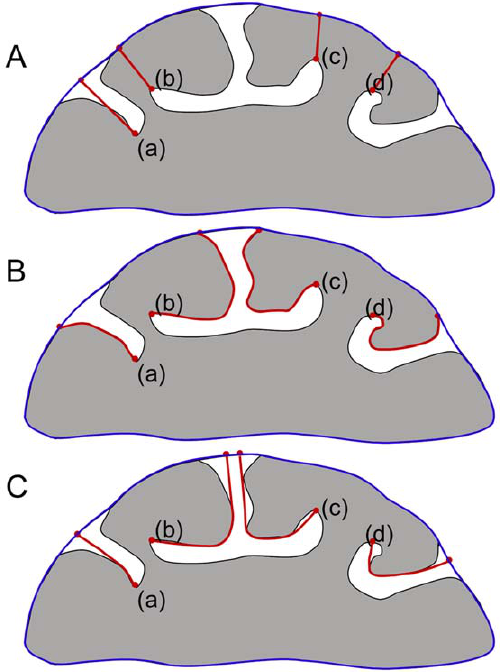
Figure 1. Illustration of algorithms for computing sulcal depth: (A) EUD, (B) GED, (C) ADT. The red lines illustrate the distance paths of each approach and the blue lines denote the convex hull, i.e., the seeds for depth calculations.